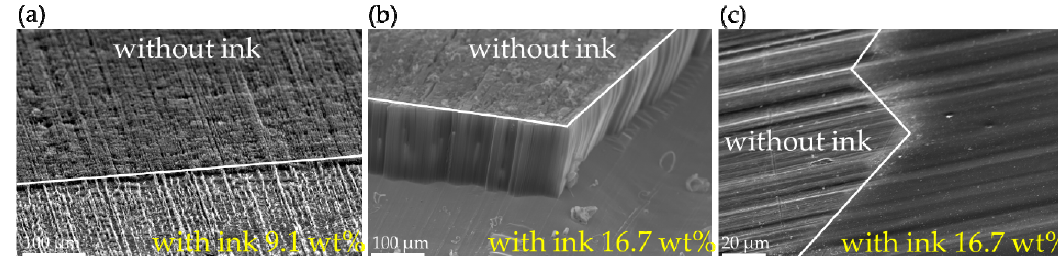
Figure 4. ( a ) At a styrene-maleic anhydride (SMA) concentration of 9.1 wt% nanotubes continue to grow, producing an unclear pattern. ( b ) At a concentration of 16.7 wt%, the pattern is clear and the covering holds. ( c ) Exposed to room temperature conditions, the film layer has already formed prior to CNT synthesis.